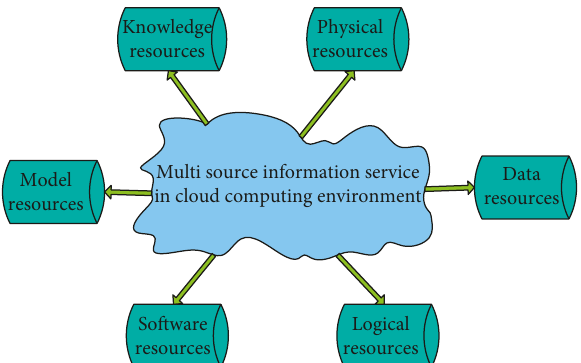
Figure 3: Composition diagram of multisource information re- sources under cloud computing services.